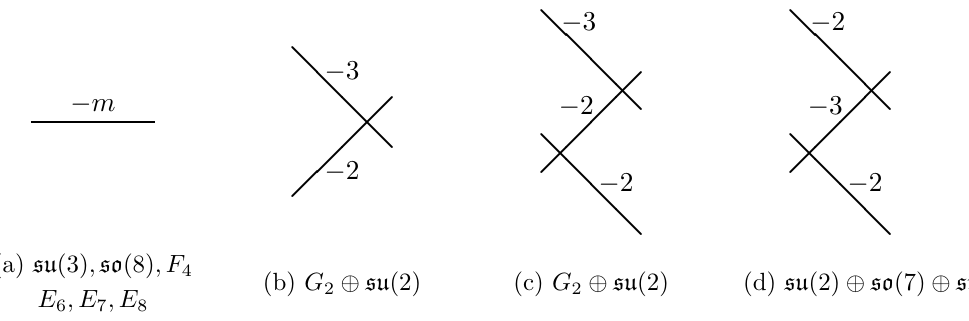
Figure 1 . Intersection numbers of bases of non-Higgsible